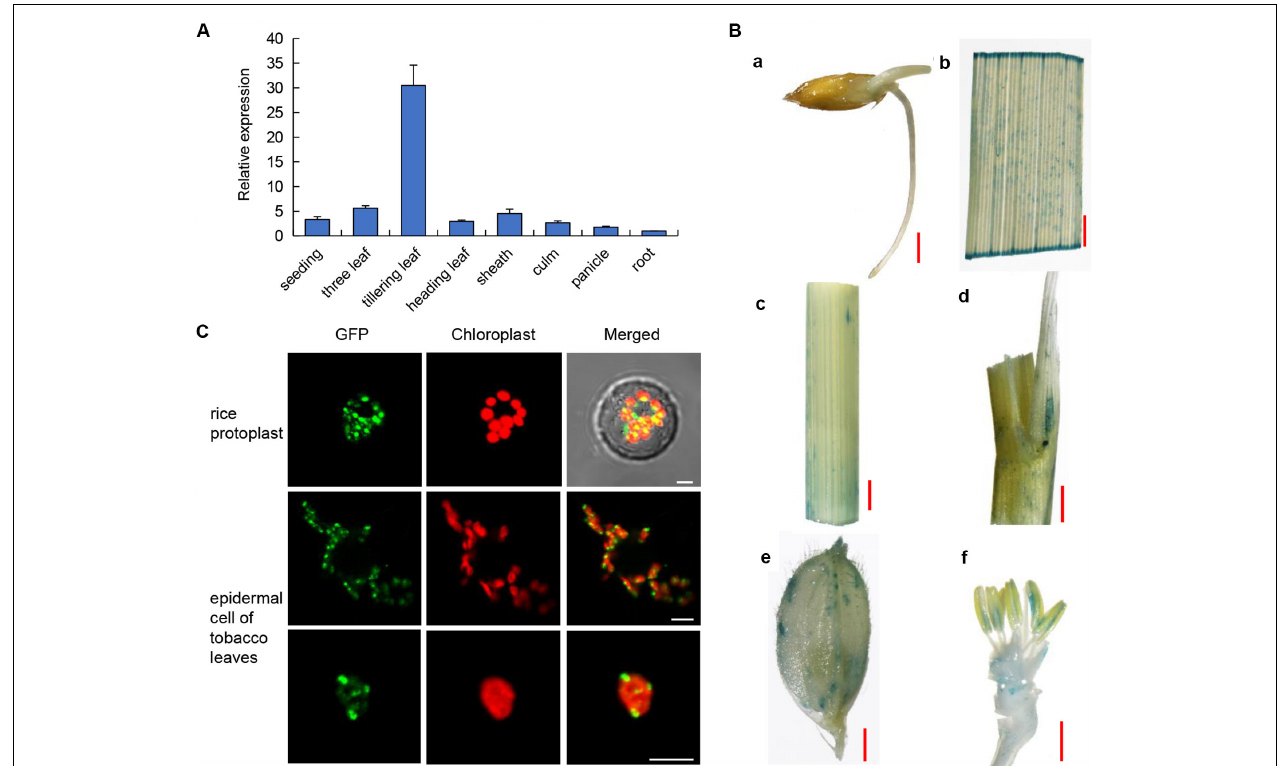
FIGURE 3 | Expression patterns and subcellular localization. (A) Expression pattern of OsPLS4. Expression in various organs, including the leaves, roots, culms, leaf sheaths, and panicles at the heading stage in the WT. The data presented are the means ± SDs of three biological replicates. (B) Spatial expression pattern of the OsPLS4 gene in transgenic rice plants harboring the OsPLS4 promoter fused to the GUS gene. (a) germinating seed; (b) spikelet; (c) stem; (d) leaf sheath; (e) tillering leaf; (f) anther. Bars = 1 mm. (C) Subcellular localization of OsPLS4 -GFP fusion constructs. The transient expression of OsPLS4-GFP fusion constructs in rice protoplasts and epidermal cells of N. benthamiana leaves was imaged by a confocal microscope. Bars = 5 nm.